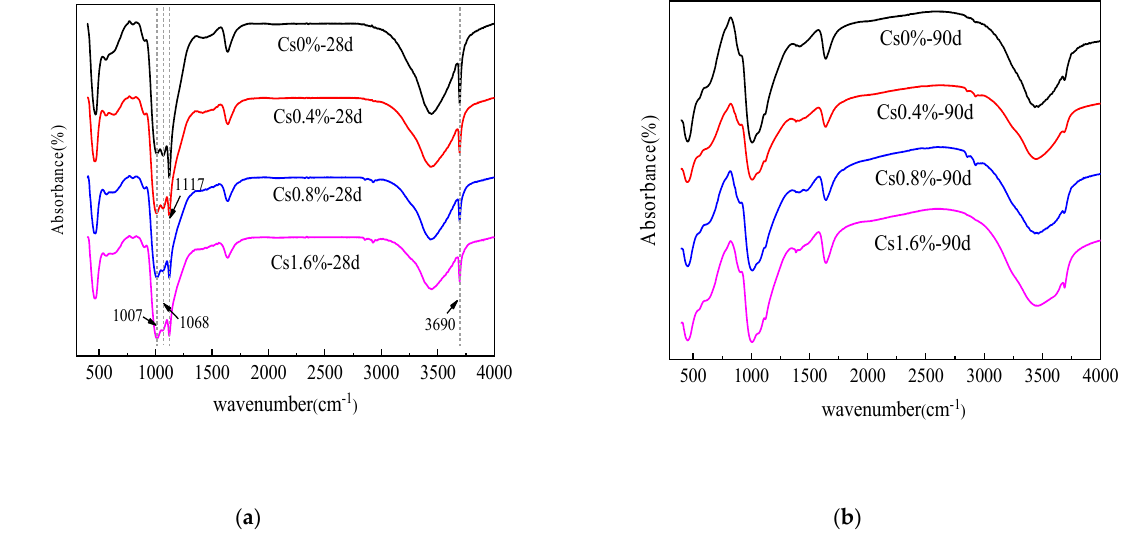
Figure 6. Fourier transform infrared spectra of the M–S–H cement-solidified body with 0 wt %, 0.4 wt %, 0.8 wt %, and 1.6 wt % Cs + contents after ( a ) 28 and ( b ) 90 d.